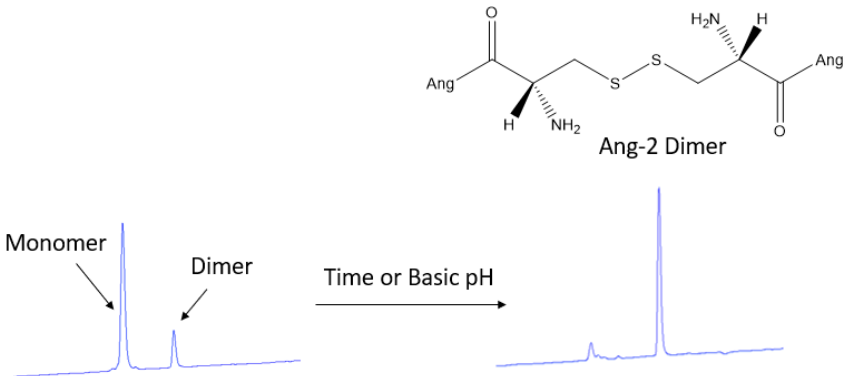
Figure 4. Chromatographic analysis obtained for the monomer (2.4 min) and the Ang–2 dimer (3.4 min) after 72 h at room temperature or adding a tris buffer solution at pH 9 only to quickly check the dimer formation.